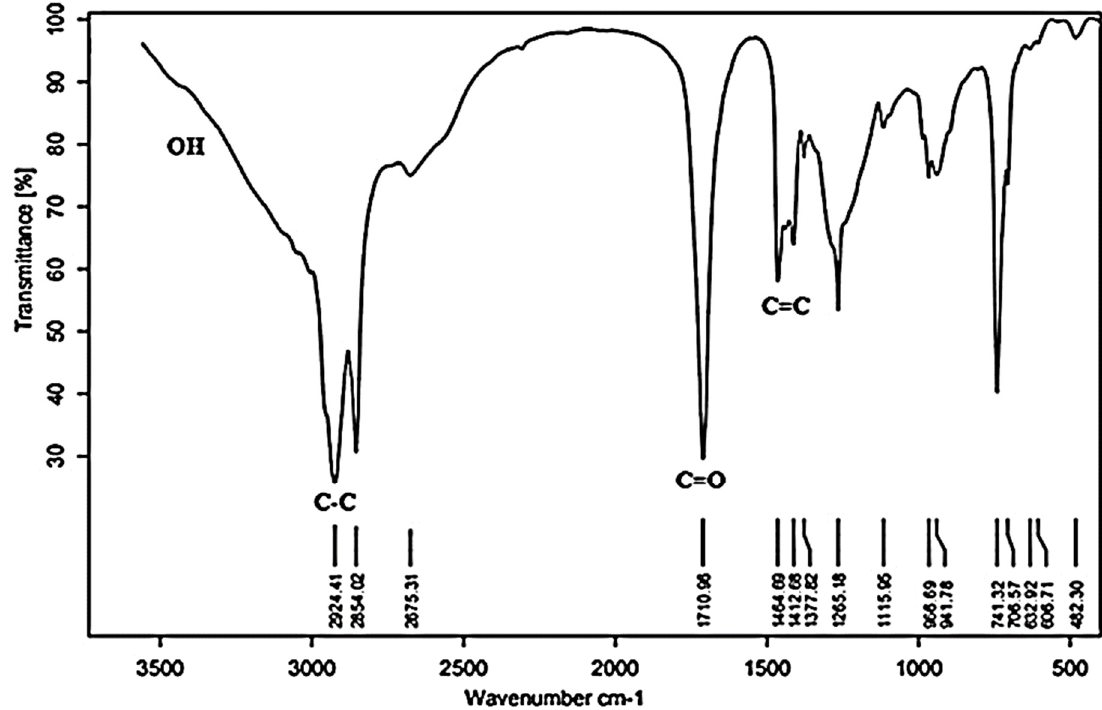
Figure 2. FTIR spectrum of the isolated biosurfactant of Candida sphaerica cultivated in medium supplemented with 9% vegetable oil refinery residue and 9% corn steep liquor.